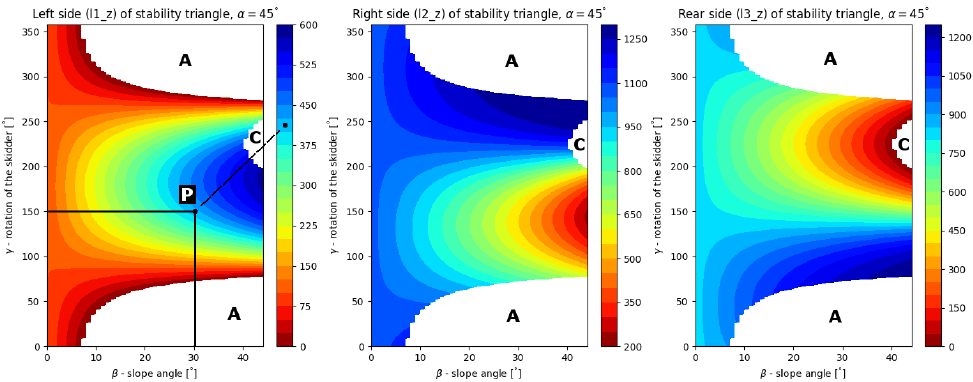
Figure 5. Example of plot in the second mode. Input parameters: α —articulation of frame (constant value), γ —rotation of skidder, β —slope angle. P—combination of input parameters, A—area of instability, due to the left side (tipping line) of stability triangle, C—area of instability, due to the rear side of stability triangle. Color bars show the distance of the gravity vector (for the whole machine, including additional loads) to tipping lines in